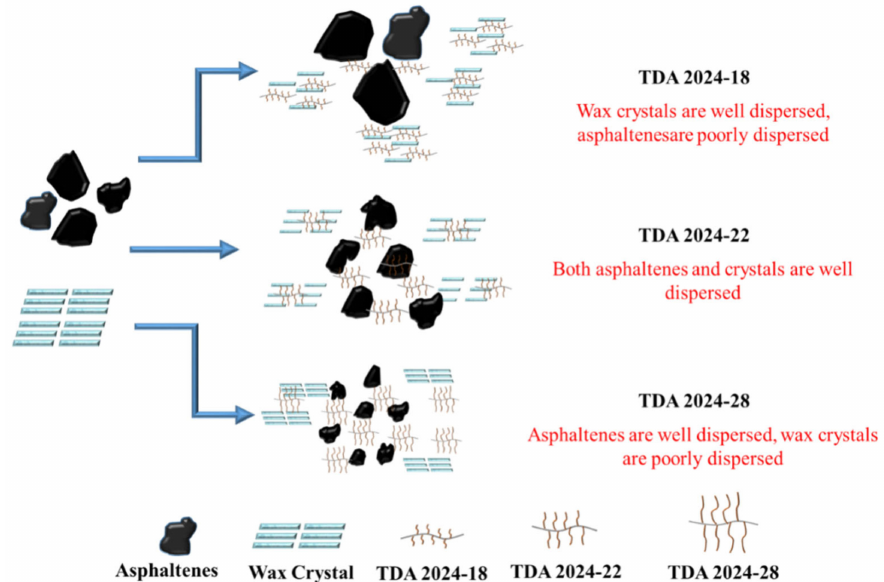
Figure 13. Improvement of oil flow by inhibiting asphaltene precipitation and wax crystallization in the presence of bipolymers with ultra-long aliphatic chain